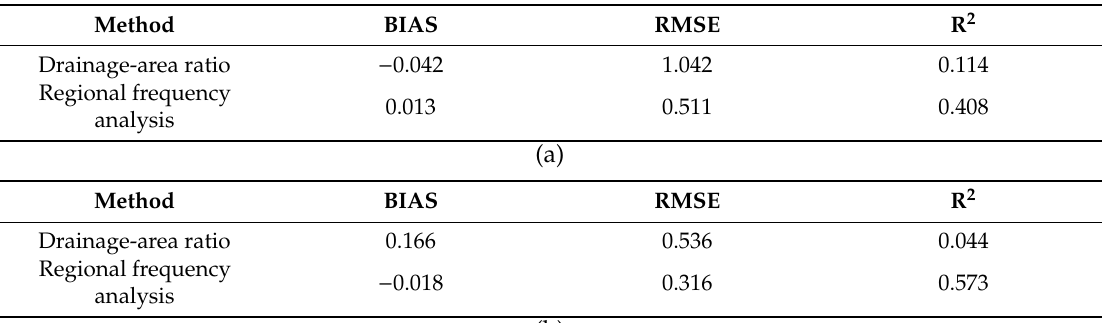
Table 6. Comparison of the validation results based on the drainage-area ratio method for the Misung station and regional frequency analysis (ensemble ANN with CCA) for the ( a ) two-year quantile and ( b ) five-year quantile derived from the Gamma